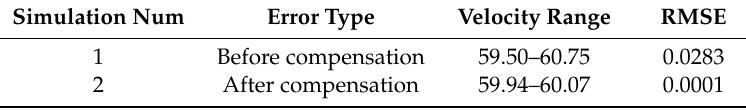
Table 6. Angular velocity tracking accuracy ( ◦ / min).